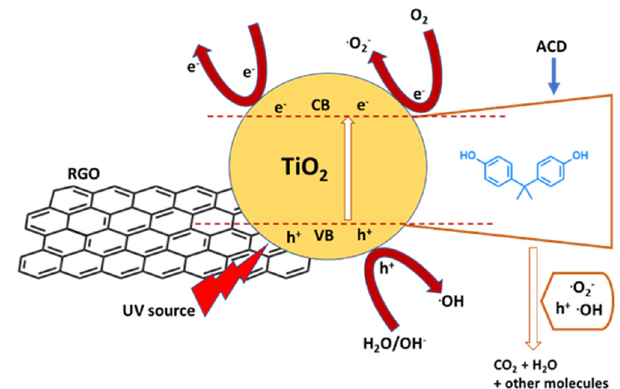
Figure 4. Reaction mechanism of photocatalytic degradation of BPA in the TiO 2 @ACD@rGO system, where ACD is aspartic acid–cyclodextrin compound. Adapted and reprinted with permission from [67], Copyright (2021) Elsevier.